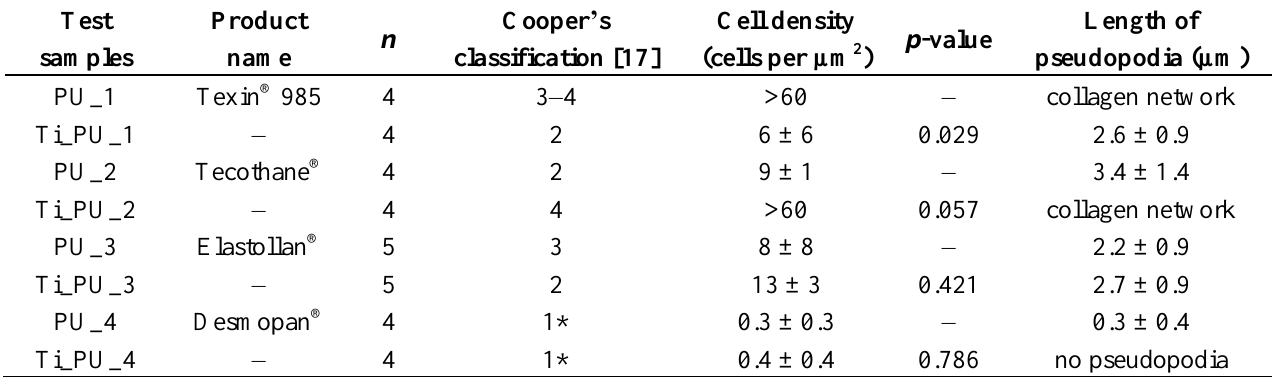
Table 1. Haemocompatibility of pure and titaniferous upgraded